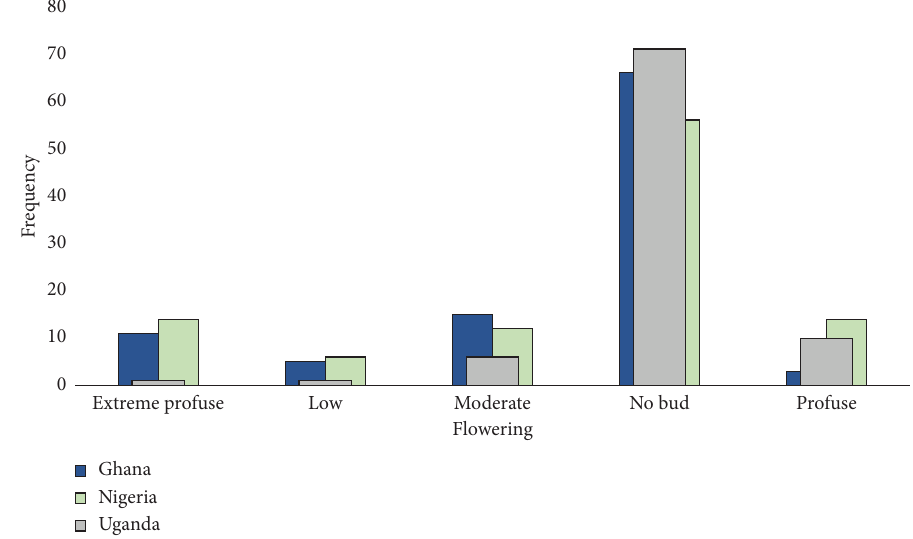
Figure 3: Phenotypic variability of plant morphology based on fowering intensity.